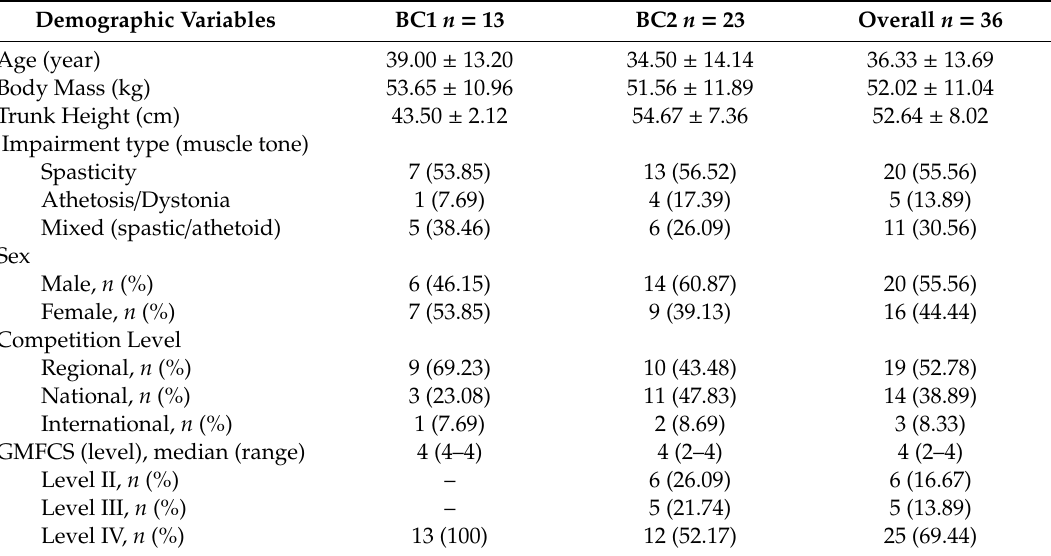
Table 1. Participants’ demographic